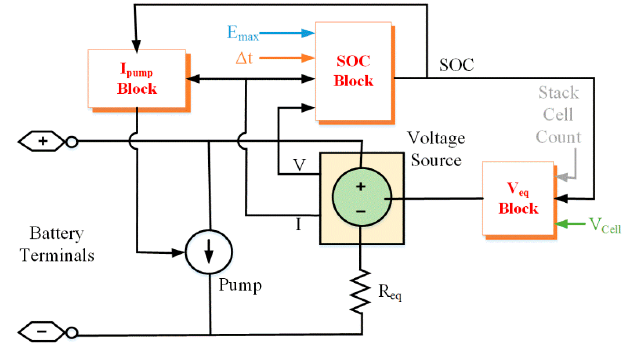
Figure 2. Block diagram of VRB battery.